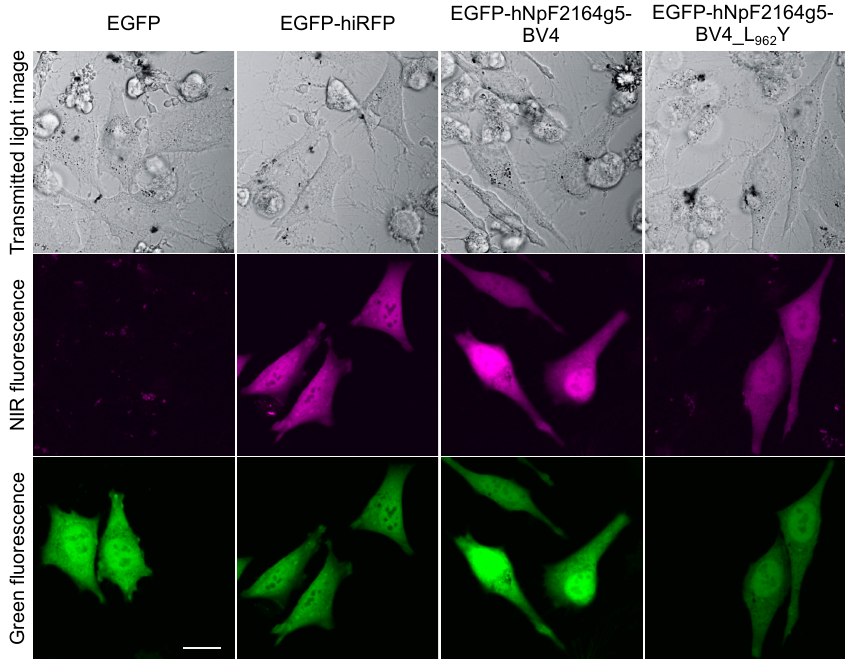
Figure 5. Fluorescence imaging in the HeLa cells using NpF2164g5_BV4_L 962 Y. Transmitted light image ( upper ), NIR fluorescence detection ( middle ), and green fluorescence detection ( lower ) for the HeLa cells expressing EGFP, EGFP-hiRFP, EGFP-hNpF2164g5_BV4, and EGFP-hNpF2164g5_BV4_L 962 Y. The cells were imaged using a confocal microscope, 48 h after transfection. Bar = 20 µm.